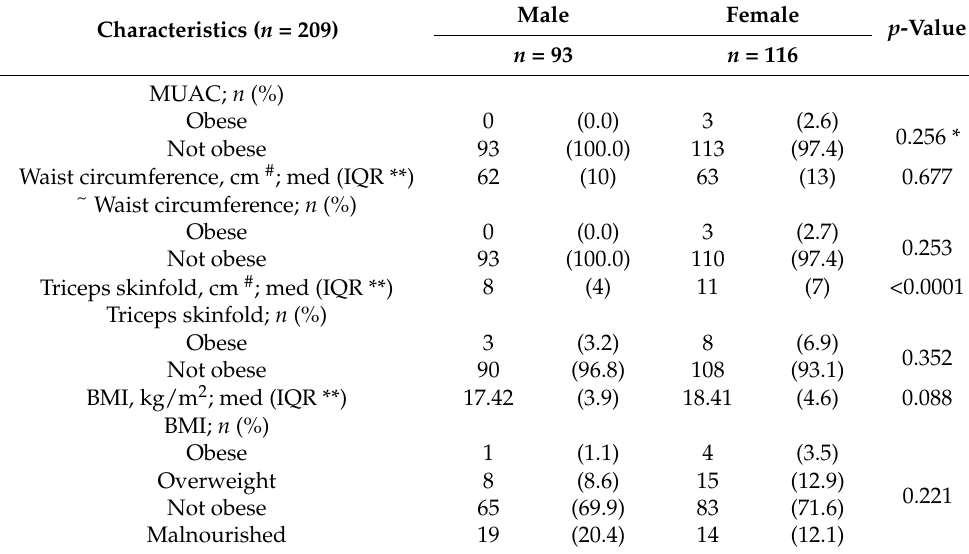
Table 2. Anthropometric measurements for children.